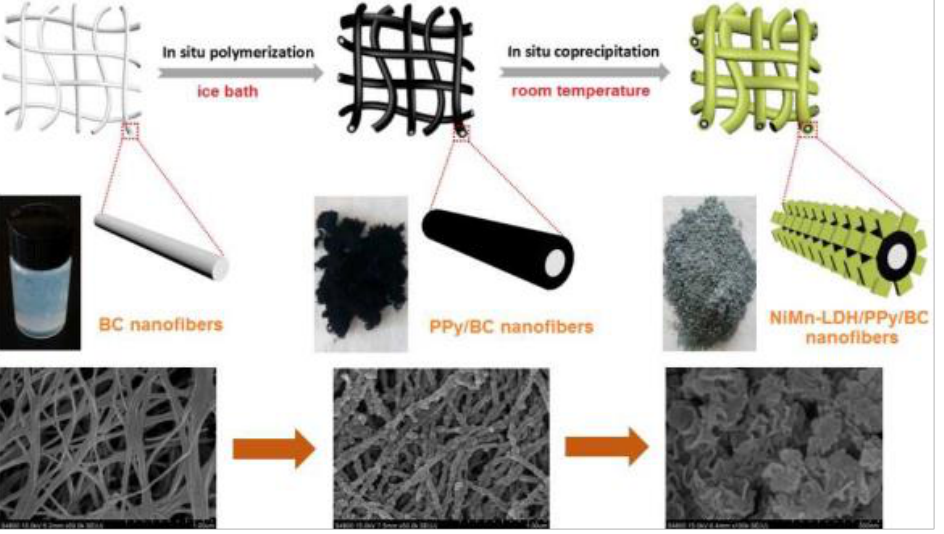
Figure 9. Schematic of layer-by-layer deposition of bacterial cellulose (BC)-supported nanocomposites and respective SEM micrographs [101]. PPy/BC = polypyrrole/bacterial cellulose; NiMn-LDH/PPy/BC = bimetallic hydroxide/polypyrrole/bacterial cellulose. Reproduced with permission from Elsevier. Table 2. Electrochemical performance comparison of bacterial cellulose electrode/nanocarbon for a supercapacitor.